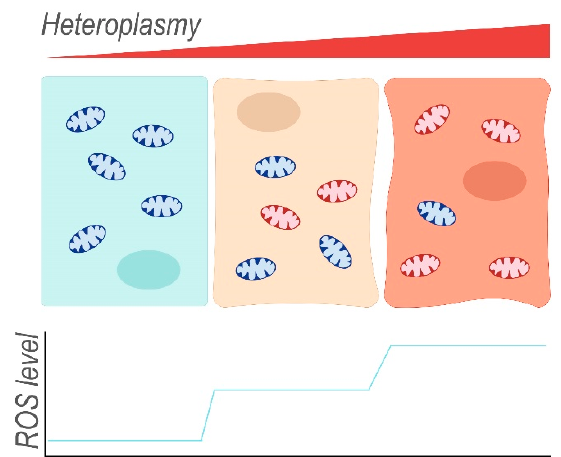
Figure 5. Concept of heteroplasmy and increasing levels of reactive oxygen species (ROS) associated with increasing heteroplasmy.